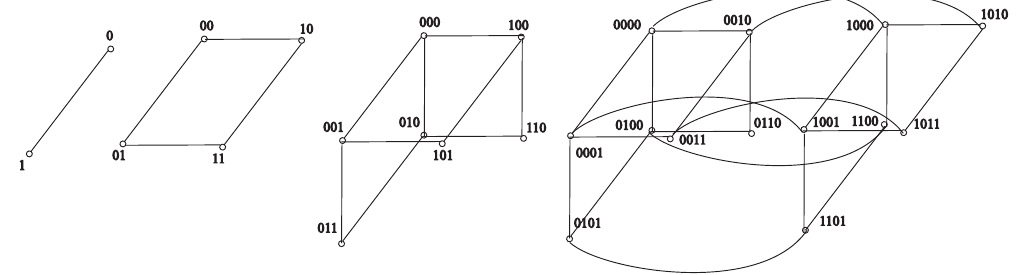
Fig. 1: the 3rd order generalized Fibonacci